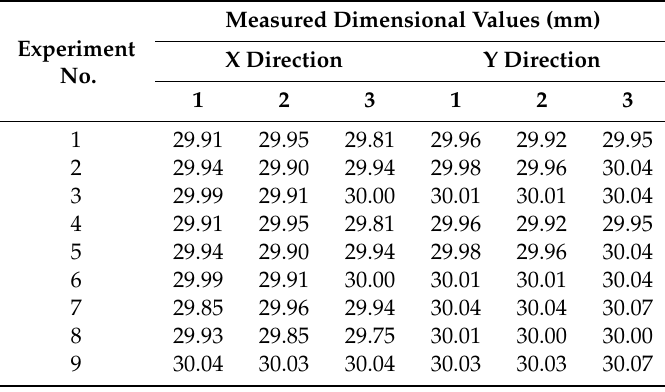
Figure 3. Measurement points for the X and Y directions. Table 3. Dimensional accuracy measurements.